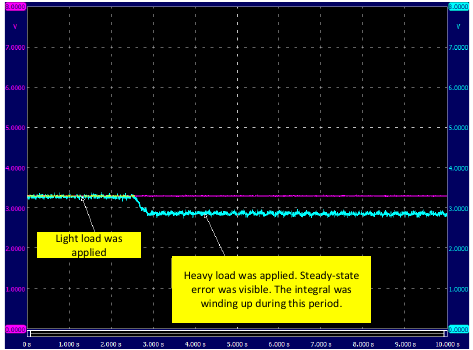
Fig. 7. Tachometer signal with steady-state error due to heavy